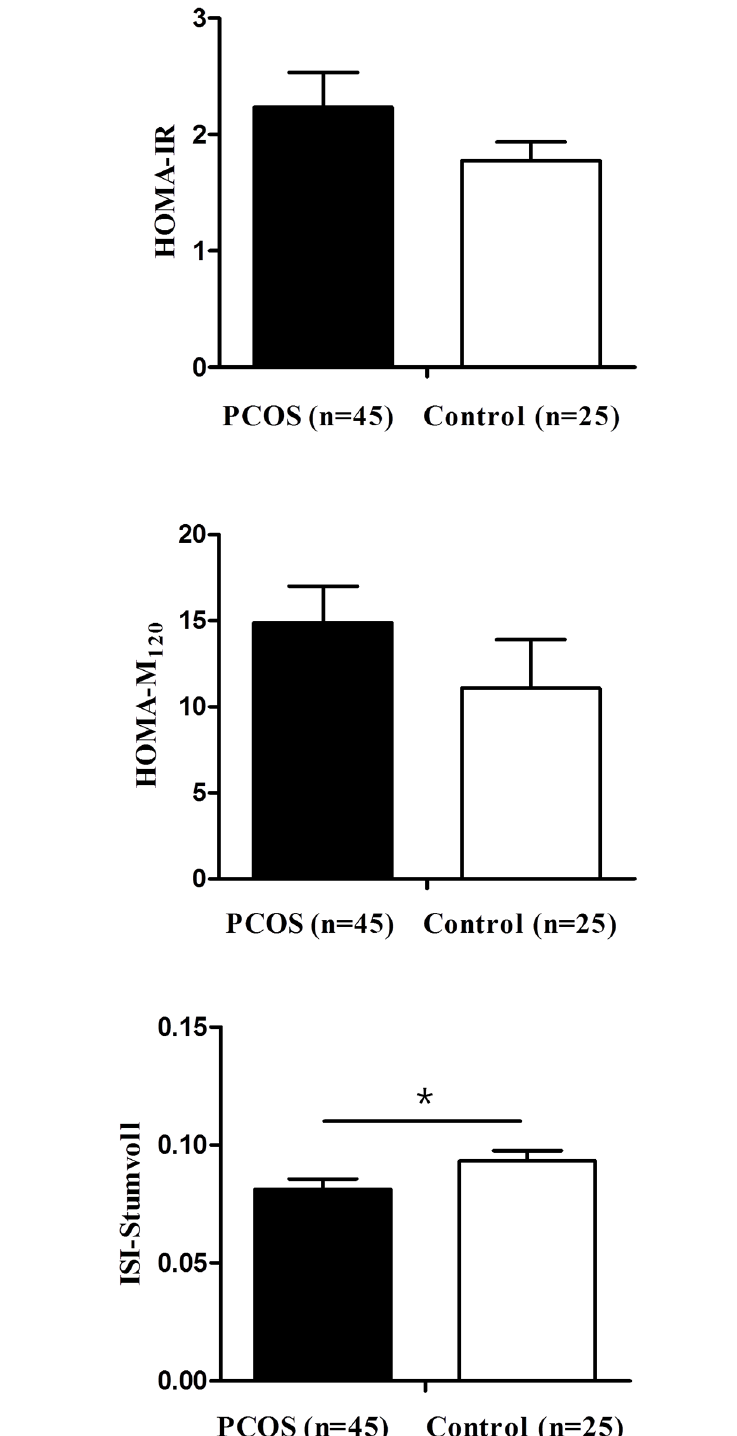
Fig 1. Comparison of insulin resistance indices in women with increased β -cell function. * P < 0.05 vs. controls. PCOS, polycystic ovary syndrome; HOMA-IR, homeostasismodel assessment of insulinresistance; ISI, insulinsensitivity